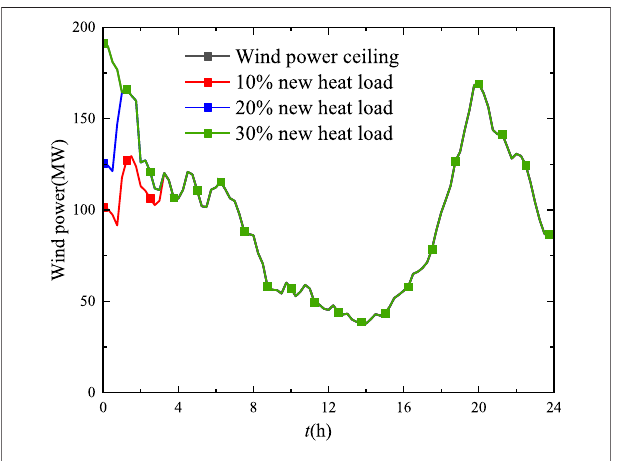
FIGURE 15 | Variations of wind power under different maximum temperatures.